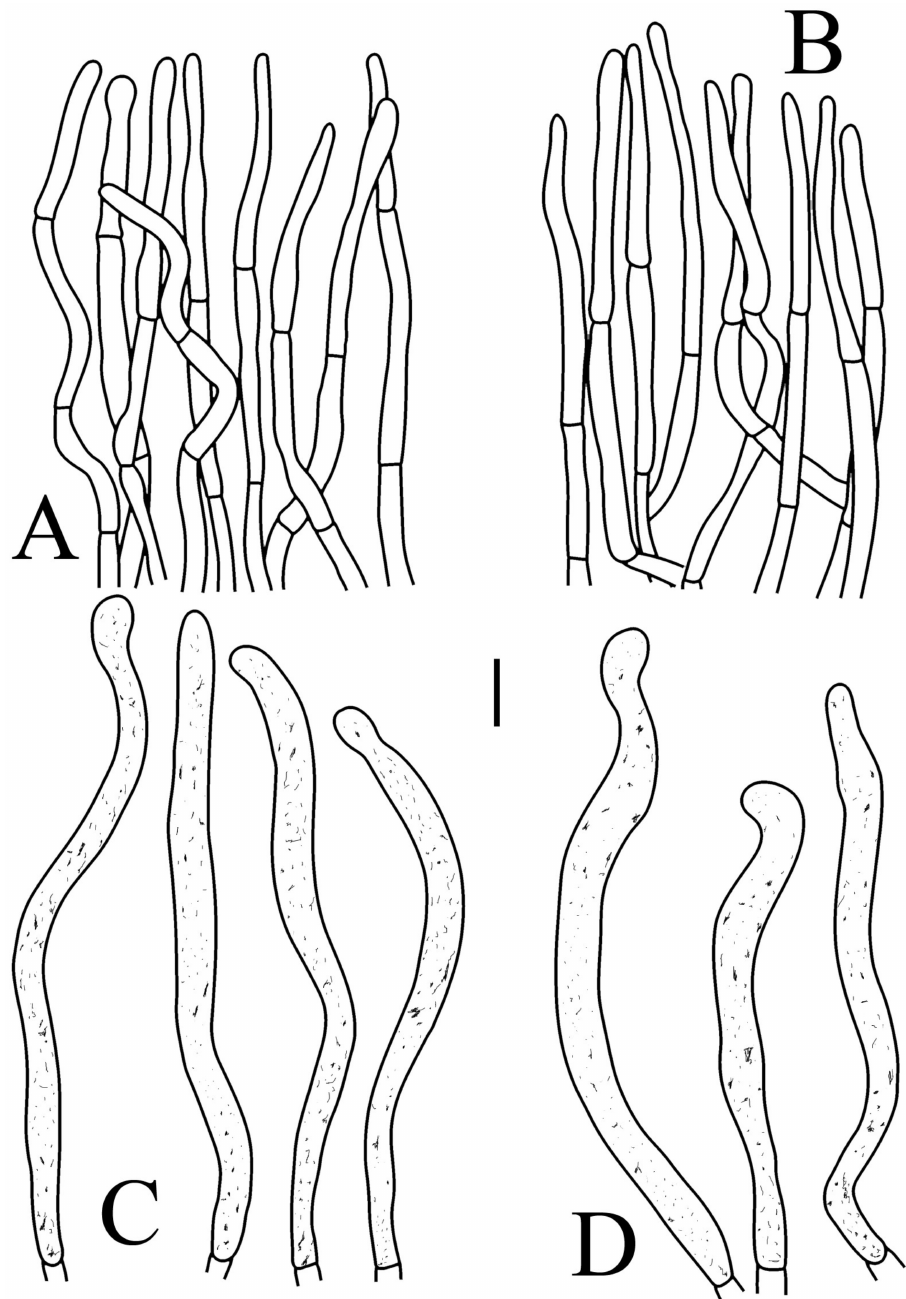
Figure 7. Russula flavescens (RITF5855, holotype): ( A ) hyphal terminations near the pileus margin; ( B ) hyphal terminations near the pileus center; ( C ) pileocystidia near the pileus margin; ( D ) pileocys- tidia near the pileus center. Scale bars = 10 µ